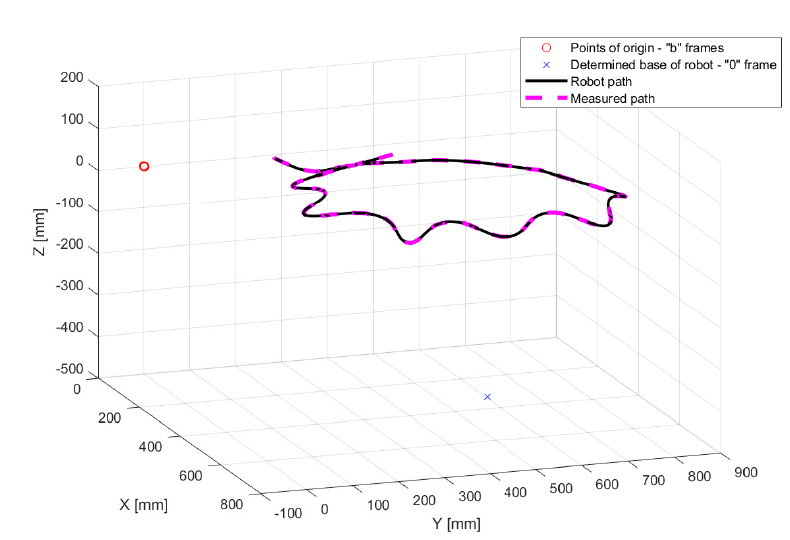
Figure 6. Measured path in comparison with the real robot path of simulation A.